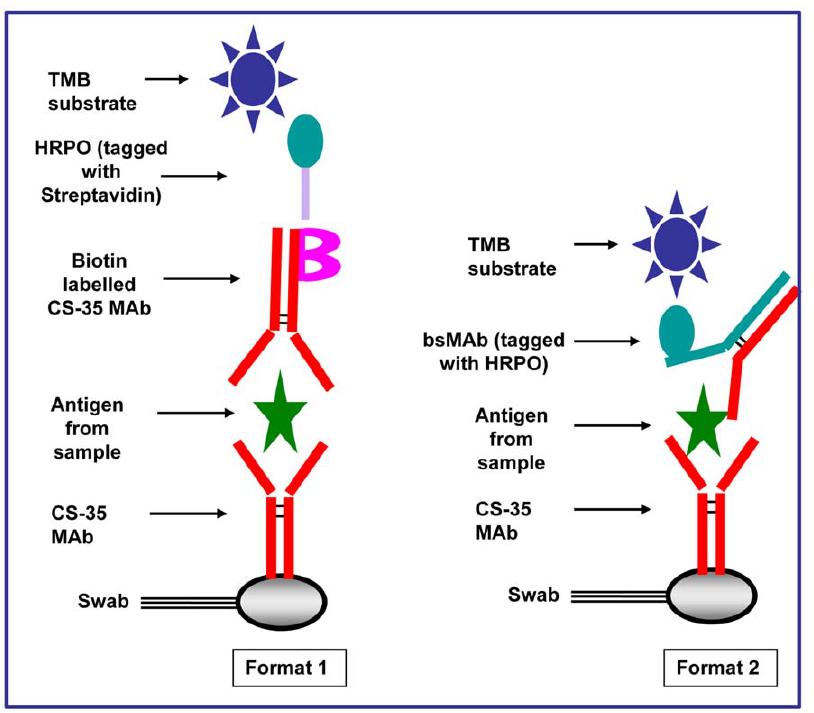
Figure 1. Two formats of sandwich ELISA. Format 1: Monoclonal antibody (MAb) based, where both the capture and detection antibody are MAb’s. Format 2: Bispecific Monoclonal antibody (bsMAb) based, where the capture antibody is a MAb but the detection antibody is a bsMAb.